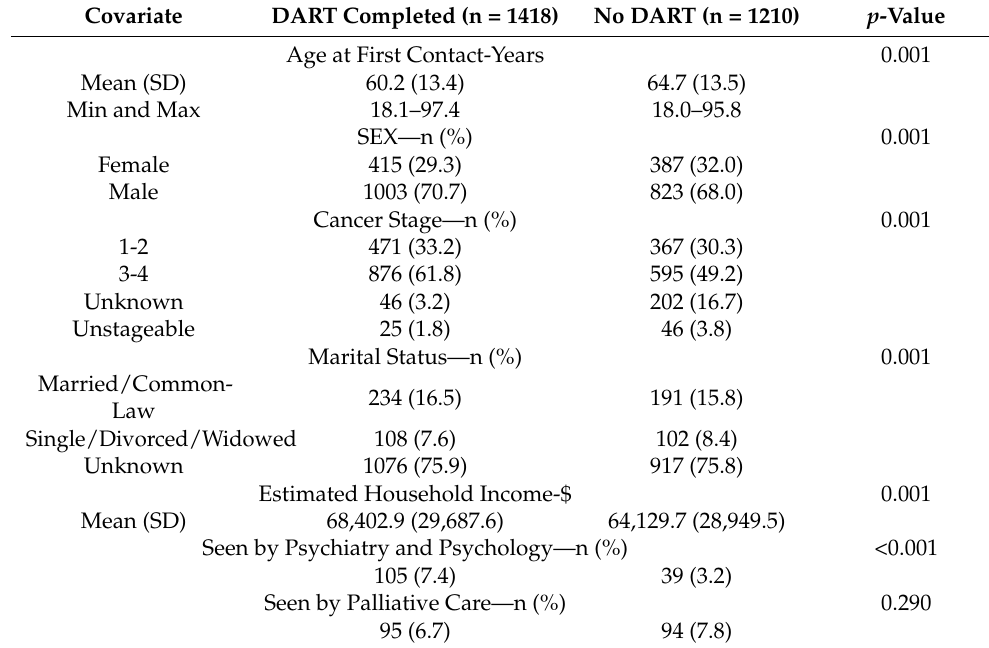
Table 6. Aim 3 cohort baseline characteristics stratified by DART completion status.